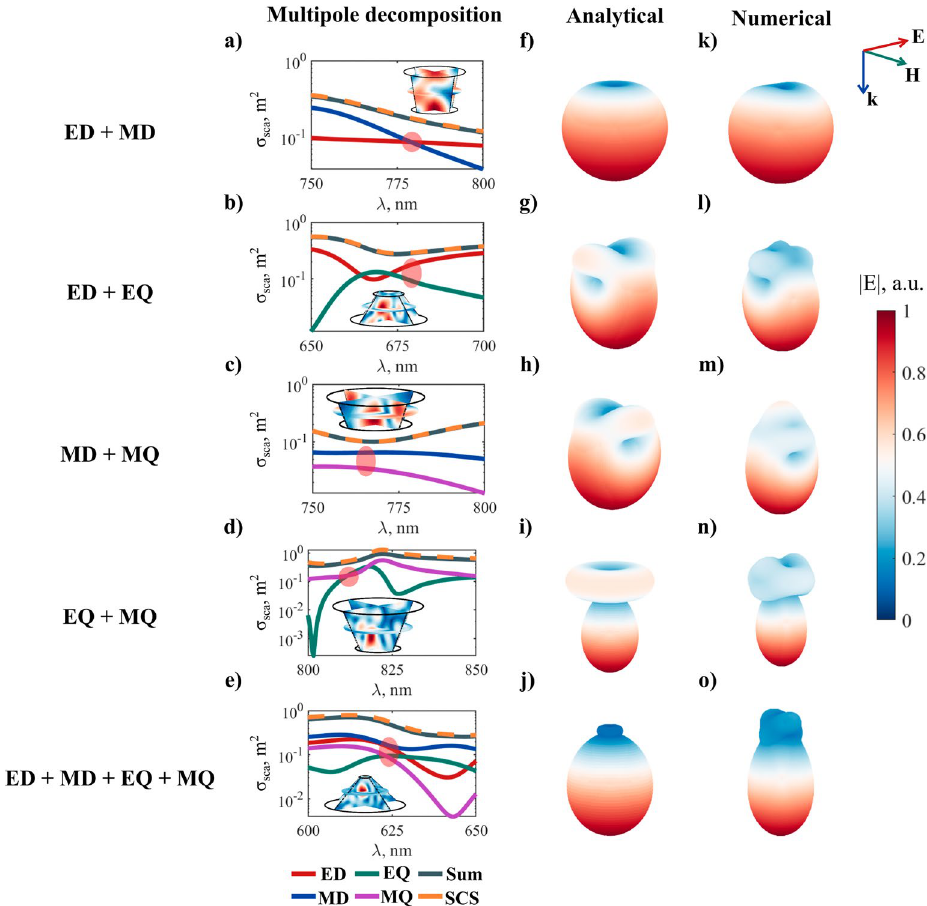
Figure 3. Generalized Kerker effects for truncated conical nanoparticles with different shapes. ( a – e )— multipolar decomposition, ( f – j )—far-field sum of multipoles for a point particle, calculated analytically, ( k – o )— far-field distribution for conical nanoparticles with different geometries calculated numerically for real particles at the spectral points shown in ( a – e ). Conditions of the illumination—incident plane wave from the top of the page. The geometrical parameters for every case can be found in section S3 of the Supplementary Information. The experimental dispersion data for a-Si is shown in Supplementary Fig.